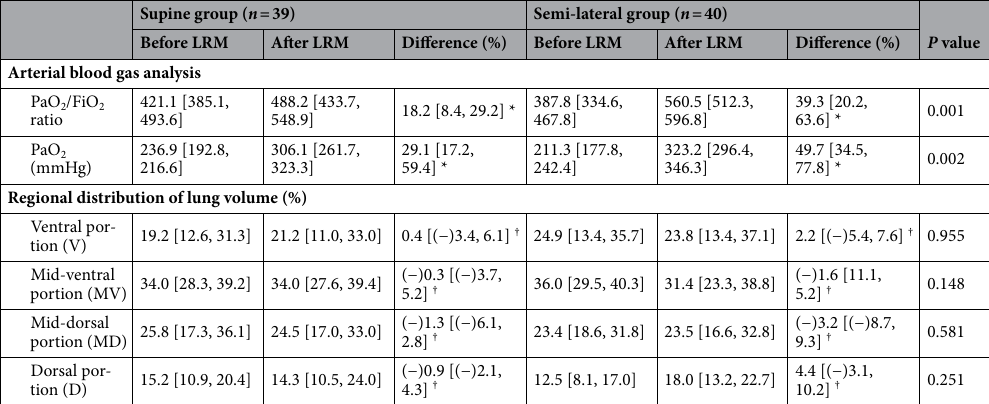
Table 3. Arterial blood gas analysis and respiratory system mechanic variables difference of before and after recruitment maneuver between groups. Data are presented as median [25th percentile, 75th percentile] after normal distribution was assessed by Kolmogorov–Smirnov test. *Difference is defined as the values after recruitment maneuver minus the values before recruitment maneuver and is expressed as a percent of the value before recruitment maneuver. † , Difference is defined as the values after recruitment maneuver minus the values before recruitment maneuver. P values compare the difference of the value before and after RM between the two groups by student t test. LRM lung recruitment maneuver, PaO 2 partial pressure of oxygen, FiO 2 fraction of inspired oxygen.